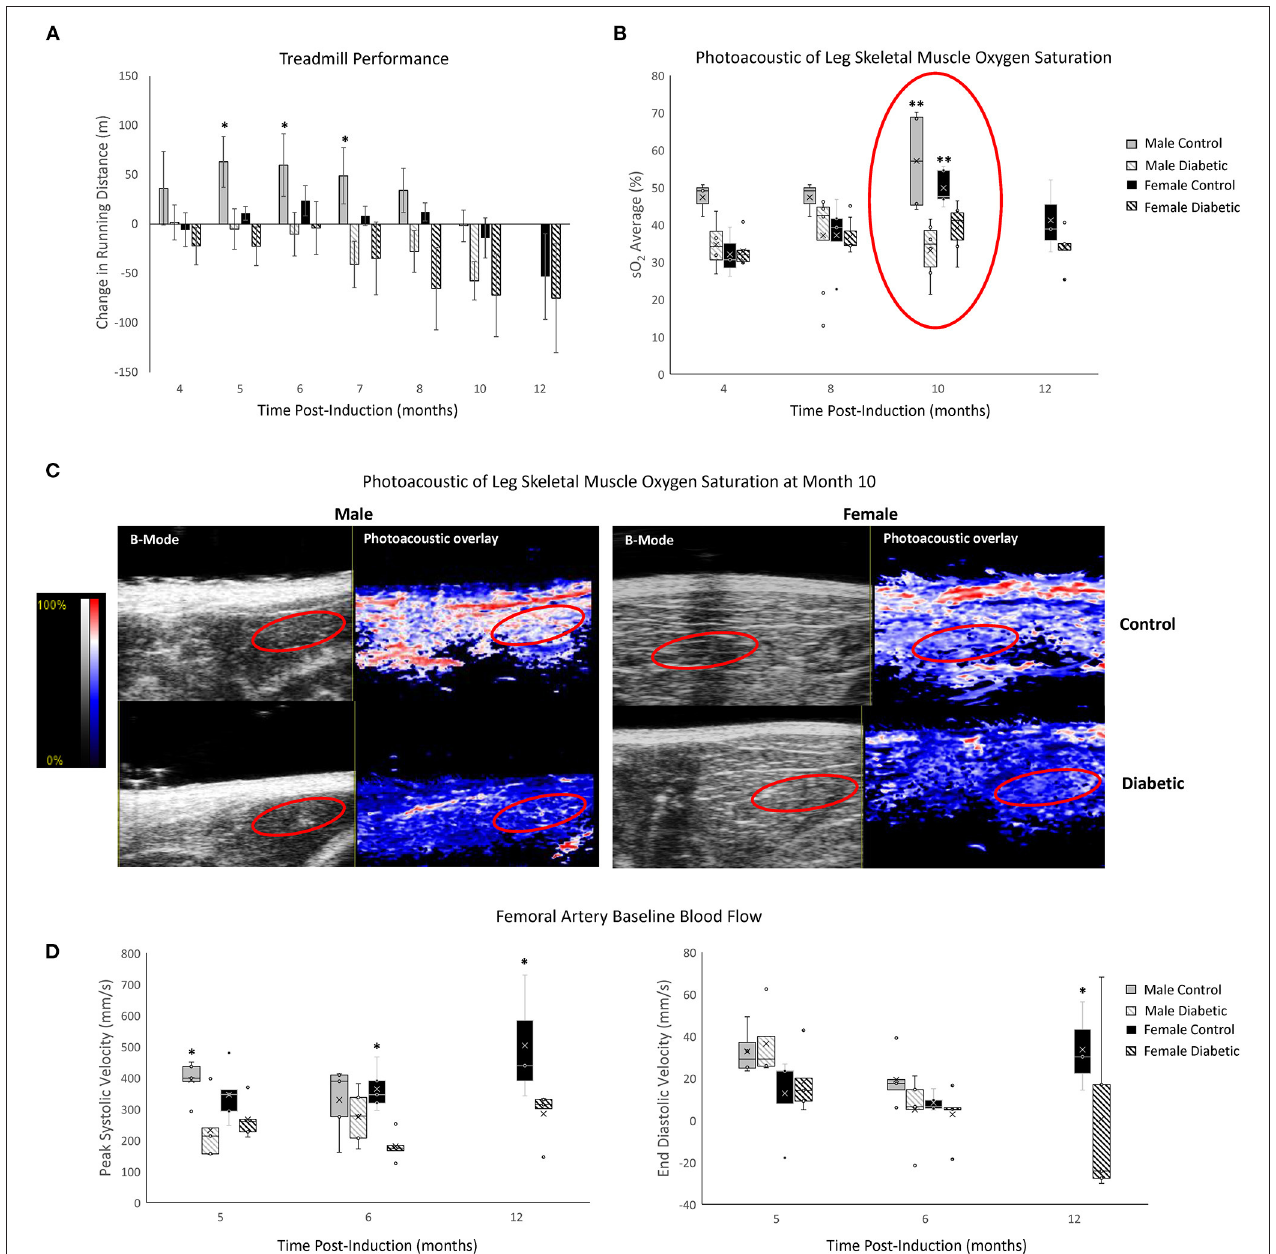
FIGURE 2 | Non-invasive evaluation of skeletal muscle microvasculature dysfunction. (A) Treadmill exercise tolerance testing. The change in running distance relative to Month 3 in individual rats is averaged for each cohort. Significance between male or female control/diabetics across all timepoints was found at p = 0.0024 and p = 0.0353, respectively. Animal numbers at 3 and 4 months ( n = 8 control male, n = 17 diabetic male, n = 8 control female, and n = 12 diabetic female), 5 and 6 months ( n = 8 control male, n = 12 diabetic male, n = 7 control female, and n = 12 diabetic female), 7 and 8 months ( n = 6 control male, n = 9 diabetic male, n = 5 control female, and n = 9 diabetic female), 10 months ( n = 6 control male, n = 8 diabetic male, n = 5 control female, and n = 9 diabetic female), and 12 months ( n = 3 control female, and n = 5 diabetic female). (B) Tissue oxygen saturation in leg skeletal muscle from photoacoustic imaging at 4 months ( n = 3 control male, n = 4 diabetic male, n = 3 control female, and n = 6 diabetic female), 8 months ( n = 3 control male, n = 8 diabetic male, n = 5 control female, and n = 7 diabetic female), 10 months ( n = 4 control male, n = 6 diabetic male, n = 5 control female, and n = 6 diabetic female), and 12 months ( n = 3 control female and n = 5 diabetic female) post-induction. (C) Photoacoustic ultrasound images of skeletal muscle at 10 months post-induction. Greyscale images are B-Mode images, and colormaps are the photoacoustic tissue oxygenation saturation overlay. (D) Baseline measurements from the femoral artery for peak systolic velocity and end-diastolic velocity measured at month 5 ( n = 5 for each of control male, diabetic male, control female, and diabetic female), month 6 ( n = 5 for each of control male, diabetic male, control female, and diabetic female), and month 12 ( n = 3 control female and n = 5 diabetic female) post-induction. Boxplot mean value is represented with the symbol “X.” Significance at individual timepoints between control and diabetic cohorts of the same sex is indicated (* p < 0.05), (** p < 0.01). Data represented as mean ± SEM.